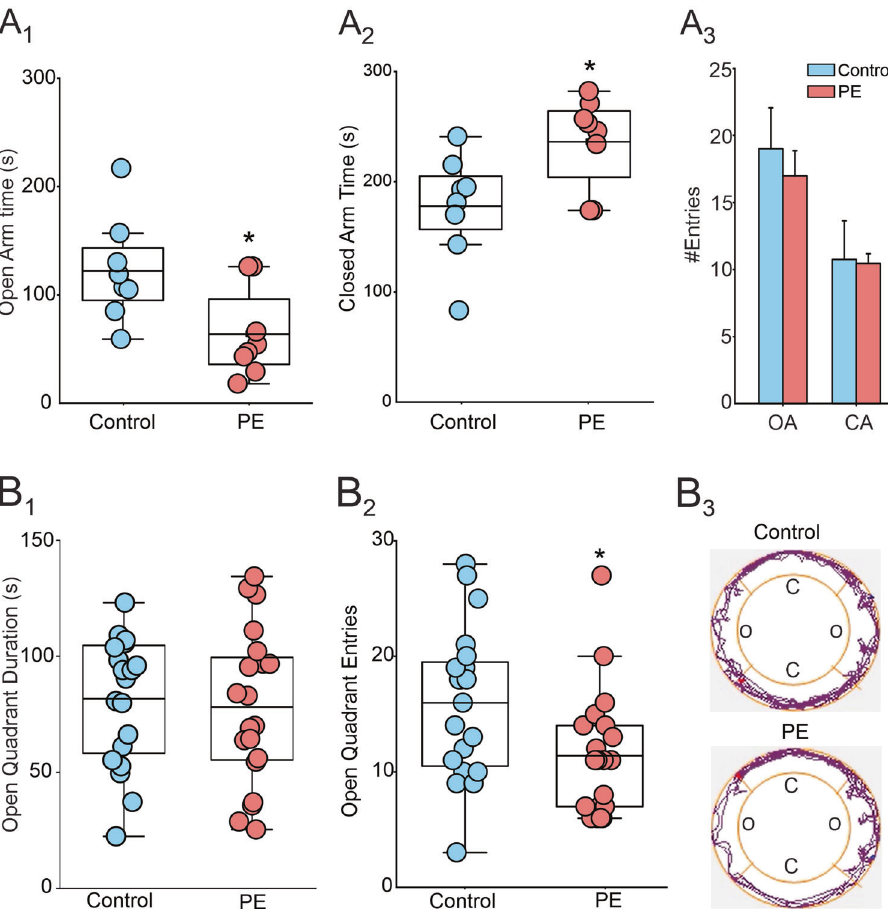
Fig. 1 Prenatal ethanol exposure causes anxiety phenotype in adult rats. A PE increases anxiety-like behavior in the elevated plus maze test. A 1 Average duration of stay in open arms of control ( ) and PE rats ( ) ( N = 8 from 4 litters, p < 0.05). A 2 Average duration of stay in closed arms ( N = 8 from 4 litters, p < 0.05). A 3 Summary graph of the average entries of control and PE rats to open and closed arms. B PE increases anxiety-like behavior in the zero-maze test. B 1 Average duration of stay in open quadrants of control and PE rats ( N = 20 from 5 litters, p > 0.05). B 2 In the elevated zero maze test, PE rats made fewer entries into the open quadrants ( N = 20 from 5 litters, p < 0.05). B 3 Representative tracking plots obtained from control (upper panel) and PE (lower panel) rats in the zero-maze test, which shows that compared with the control rat, the PE rat travelled mostly on quadrants that they were initially placed on, reluctant to venture out to the farther quadrants.*: p < 0.05, independent-samples t-tests, N number of persistent potentiation of glutamate release in the DRn. Consistent Prenatal ethanol exposure potentiates glutamate synapses of with this conclusion, we also found that compared to control rats, DRn 5-HT neurons PE (Control: The fi ring activity of DRn 5-HT neurons is tightly regulated by the 4.56 ± 0.44 Hz; PE: 9.77 ± 0.67 Hz; Fig. 3B 1 -B 2 ) as indicated by the strength of their excitatory inputs [35, 36]. Consequently, the increased activity of DRn 5-HT neurons in PE rats could be mediated by a potentiation of DRn glutamate synapses. We fi rst tested this possibility by examining whether blockade of glutamatergic average amplitude (Control: 13.53 ± 1.09 pA; PE: 14.38 ± 1.63 pA; transmission can reverse the increased activity of 5-HT neurons in Fig. 3B 4 ), the cumulative distribution (K-S test: p > 0.05, Fig. 3B 5 ) PE rats. We found that administration of DNQX (20 µM) and AP-5 and decay kinetic of mEPSCs (Tau control: 5.12 ± 0.36 ms; Tau PE: (20 µM), antagonists of α -amino-3-hydroxy-5-methyl-4-isoxazole 5.59 ± 0.31 ms; Fig. 3C 1 -C 2 ), indicating the PE did not alter the propionic acid receptor (AMPAR) and N-methyl-D-aspartate receptor function of postsynaptic AMPARs. Taken together, these results (NMDAR), respectively, signi fi cantly reduced the PE-induced activa- tion of 5-HT neurons (PE: 0.37 ± 0.04 Hz; PE + DNQX & AP5: 0.16 ± 0.02 Hz; Fig. 2B 1 -B 2 ). Such a fi nding indicates that a persistent potentiation of DRn glutamate synapses contributes to the PE- induced activation of 5-HT neurons. Next, to directly examine the impact of PE on glutamate synapses, we assessed the probability of glutamate release using the paired-pulse ratio (PPR) and coef fi cient of variation (CV) of eEPSCs. Compared to control, PE signi fi cantly reduced the PPR (Control: 1.30 ± 0.03; PE: 1.13 ± 0.02; Fig. 3A 1 -A 2 ) and CV of eEPSCs (Control: 0.47 ± 0.02; PE: 0.33 ± 0.01; Fig. 3A 3 ), thereby indicating